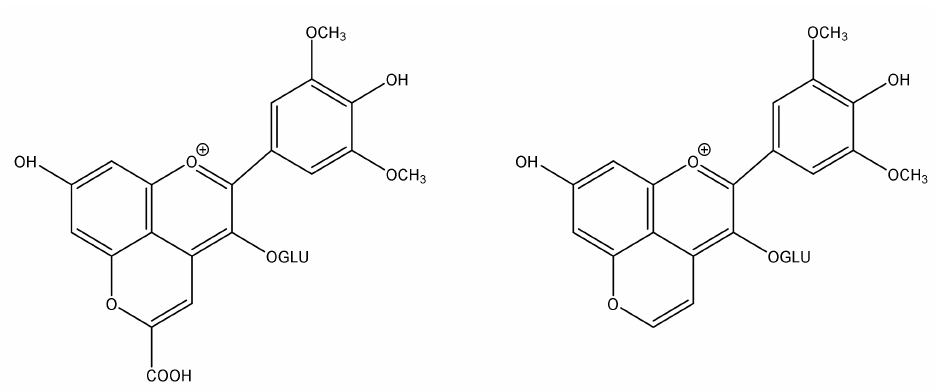
Figure 2. Reaction mechanism involving malvidin-3- O -glucoside and carbonyl compounds.